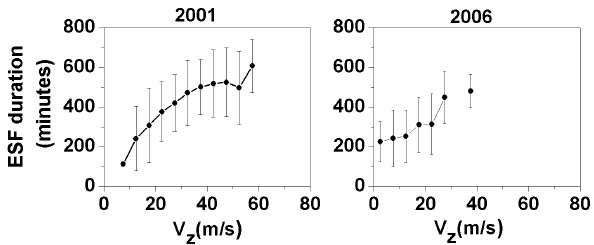
Fig. 1. Plot of the average ESF duration, with the standard devia- tion, against the PRE drift velocity ( V z ) , taken in intervals of 5m/s, for the solar maximum and minimum years of 2001 and